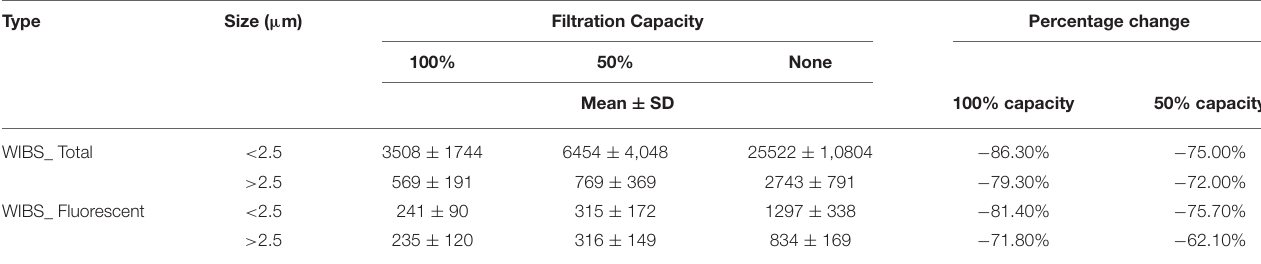
TABLE 3 | Average particle counts (#/cm 3 ) measured by the WIBS during the different operational modes of the filtration unit in the boning hall and the associated reduction when compared to no filtration.